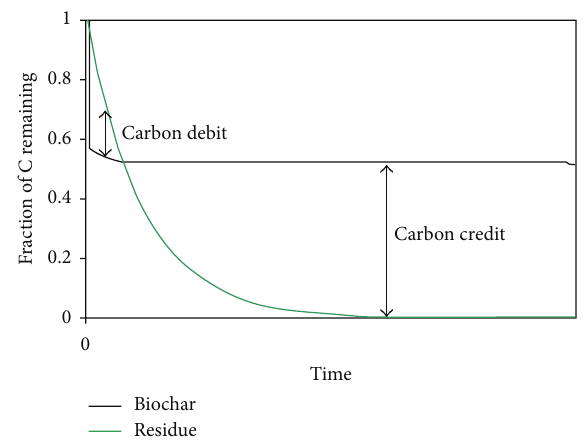
Figure 2: Impact of biomass pyrolysis with soil application of biochar on the amount of original biomass C remaining in the soil relative to the amount of C remaining in the soil if the same biomass is returned to the soil as a biological residue (source: Laird et al., 2009